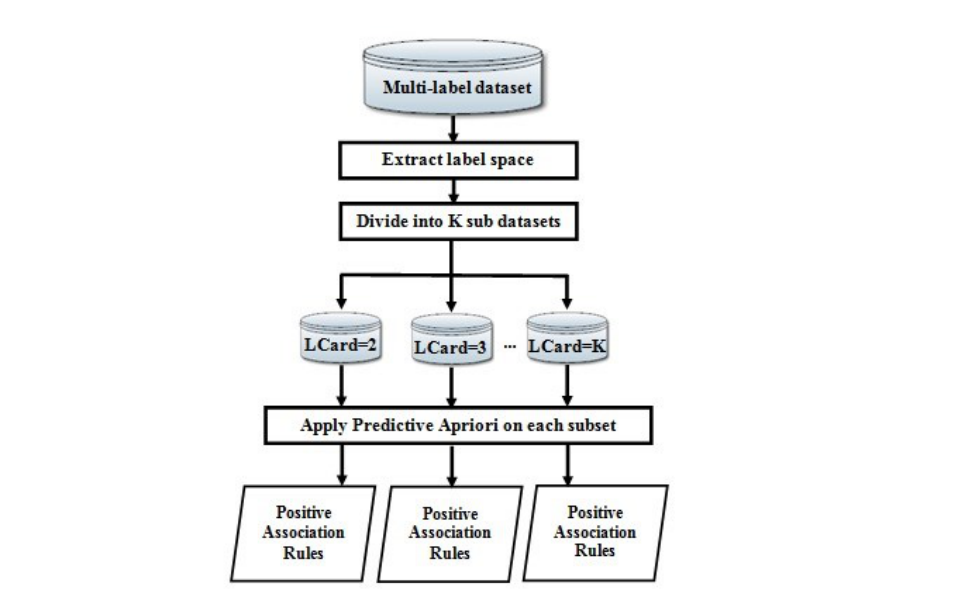
Figure 4. Dividing the input dataset into several